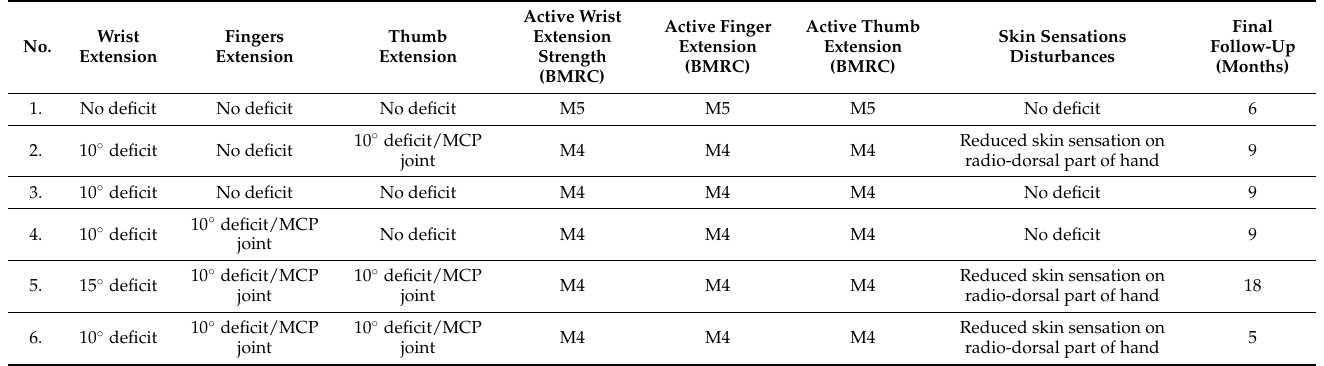
Table 3. Results of extension, active muscular hand strength and sensations